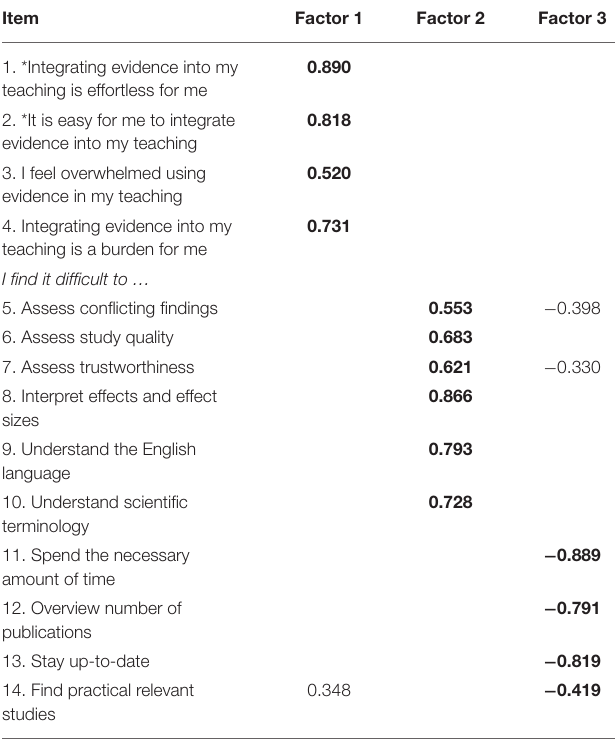
TABLE 1 | Results of the exploratory factor analysis ( N = 58).